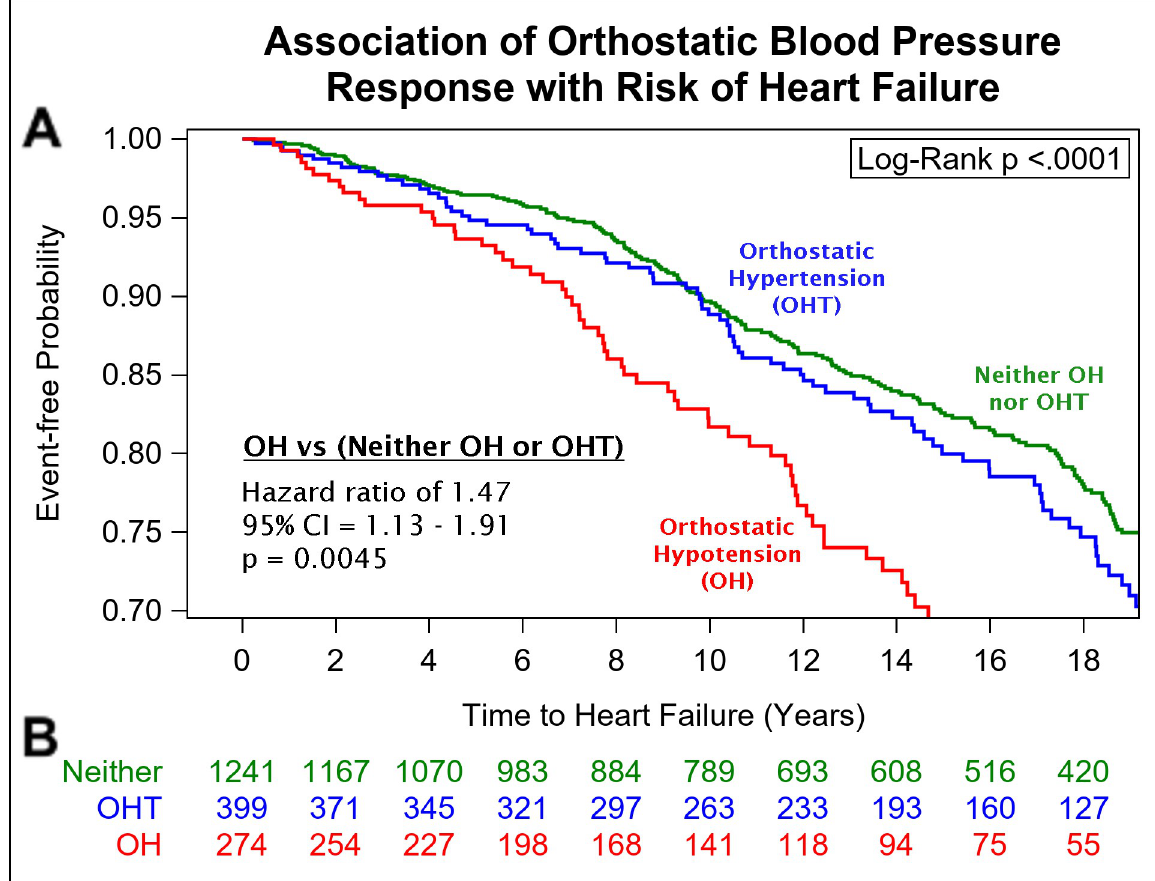
Fig 1. Kaplan-Meier curve for heart failure risk by orthostatic blood pressure response. (A) Presence of OH at baseline was associated with a 1.5 times higher risk of incident HF when compared to a normal (neither OH nor OHT) orthostatic BP response (multivariable-adjusted model HR 1.47, 95% CI 1.13–1.91, p = 0.0045). (B) Participants at risk per follow-up year. OH indicates orthostatic hypotension; OHT, orthostatic hypertension; HR, hazard ratio.